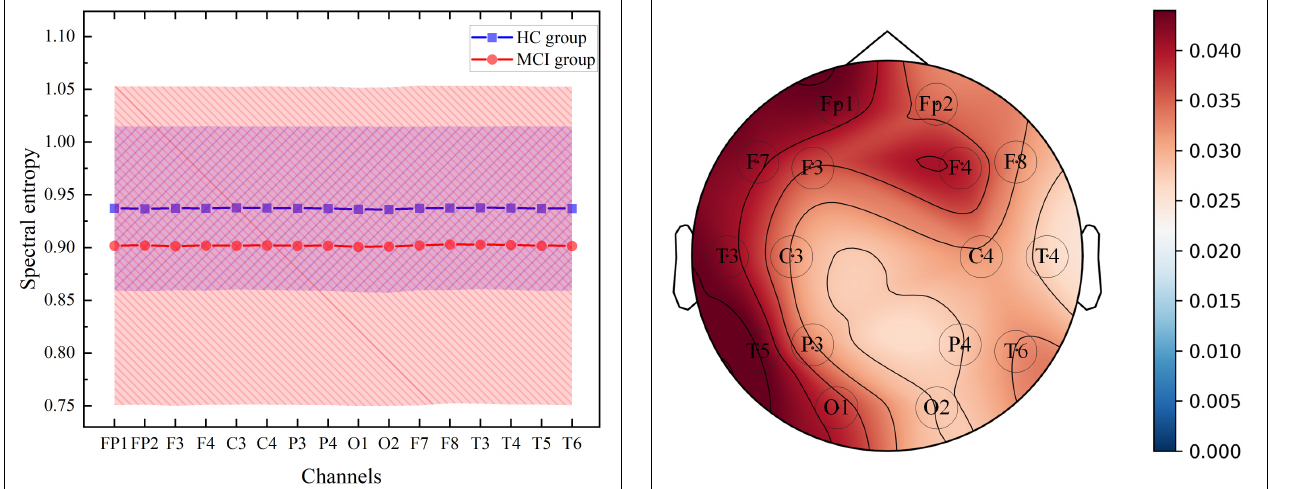
FIGURE 11 | Spectral entropy values corresponding to 16 channels.